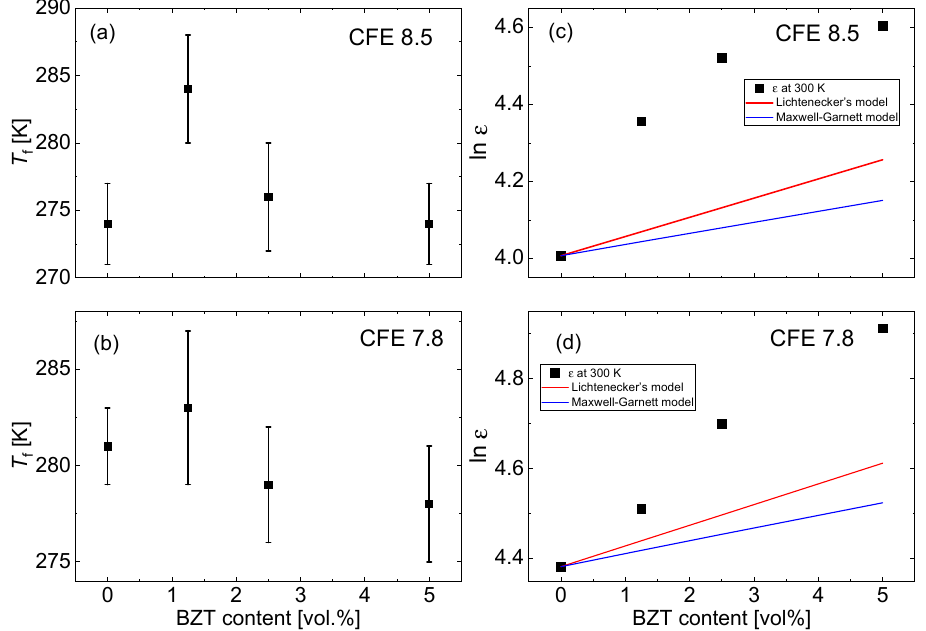
Figure 3. The freezing temperature, T f , according to the Vogel–Fulcher fit of T m ( f ) dependences for P(VDF-TrFE-CFE) 68/32/8.5 ( a ), and P(VDF-TrFE-CFE) 64.8/35.2/7.8 ( b ) based composites with different BZT contents. Dependences of the dielectric permittivity (at T = 300 K and f = 1 kHz) on the BZT content for P(VDF-TrFE-CFE) 68/32/8.5 ( c ), and P(VDF-TrFE-CFE) 64.8/35.2/7.8 ( d ) based composites. The straight lines show the dielectric permittivity of the composites calculated according to the Lichtenecker and Maxwell–Garnett models.